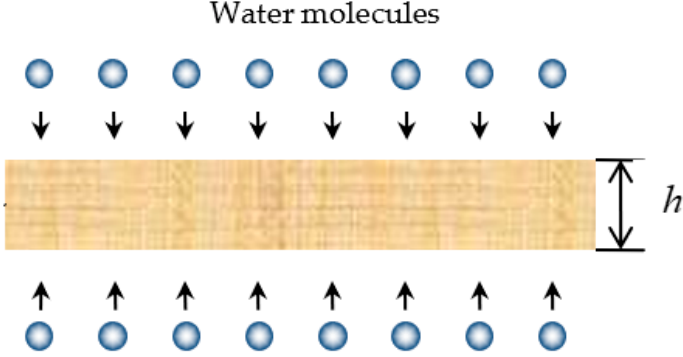
Figure 2. Time fractional diffusion equation for moisture uptake of the material.